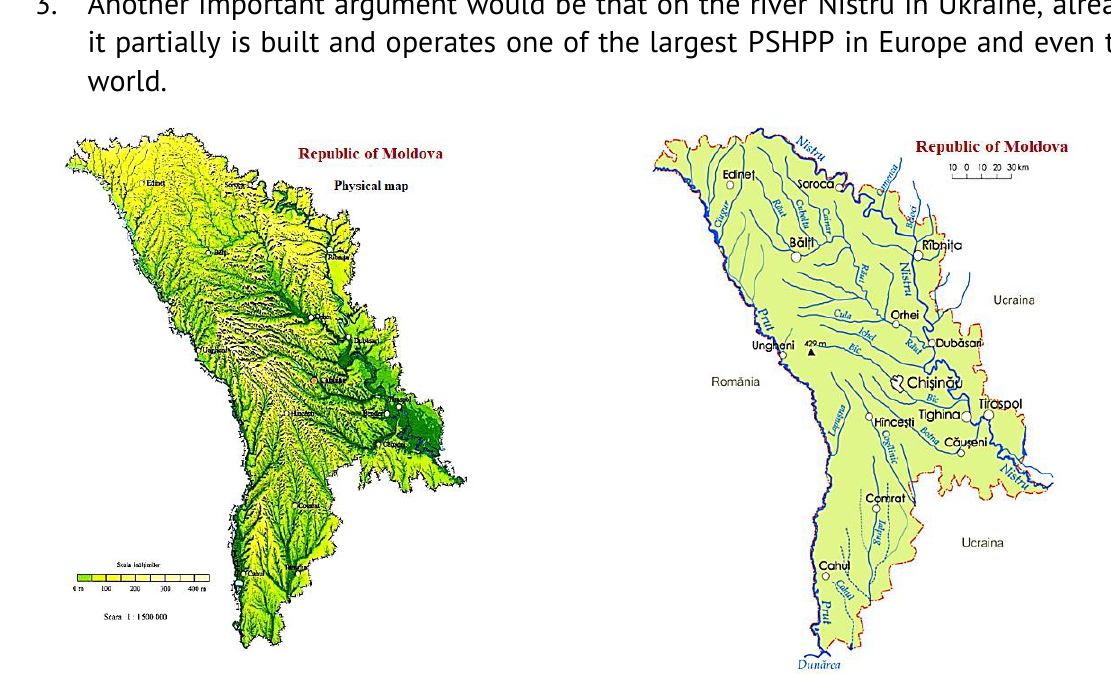
Figure 2. Physical map (a) and map of the main rivers (b) of the Republic of Moldova. Possible locations along the Nistru and Prut rivers